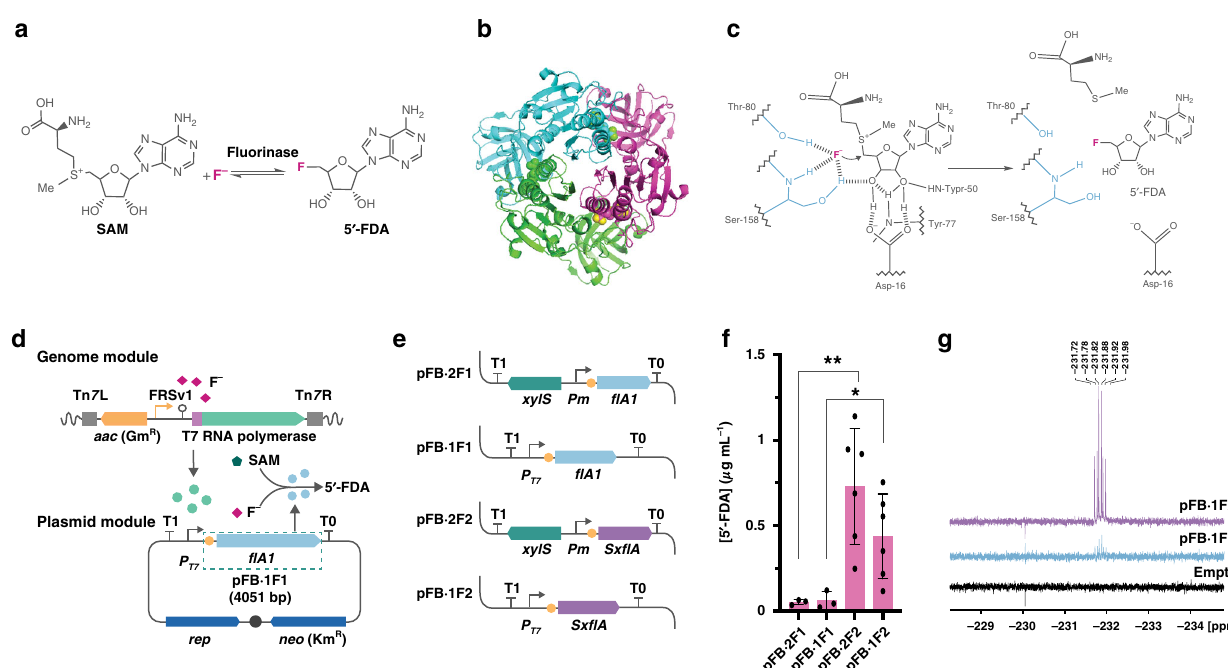
Fig. 2 In vitro bio fl uorination in cell-free extracts of engineered P . putida . a Bio fl uorination reaction, indicating the transformation of SAM ( S -adenosyl-L- methionine) and F − into 5 ′ -FDA (5 ′ - fl uoro-5 ′ -deoxyadenosine) by the fl uorinase enzyme. b 3D structure of the trimer form of fl uorinase (PDB ID 1RQP); SAM bound to the enzyme is represented as yellow spheres. c Mechanism of action of the fl uorinase enzyme. Functional groups that interact with F − (magenta) are indicated in blue. d Scheme of the synthetic circuit designed for fl uoride-triggered bio fl uorination. The T7 RNA polymerase gene (dark green) is integrated in the genome; upon exposure to F − (pink squares), the P T7 → fl A1 module (light blue, borne by plasmid pFB·1F1) is expressed and the FlA1 fl uorinase (light blue circles) is produced, catalyzing the conversion of SAM (green pentagon) and F − into 5 ′ -FDA. FluoroBrick 1, containing an RBS (yellow circle) and fl A1 , is boxed with dashed green lines. e FluoroBricks tested for 5 ′ -FDA biosynthesis. Genes encoding fl uorinases from Streptomyces sp. MA37 ( fl A1 ) and S. xinghaiensis ( Sx fl A ) were combined with the XylS/ Pm expression system or the FRS-T7 RNA polymerase circuit described in ( d ) by modular assembly. f 5 ′ -FDA biosynthesis in cell-free extracts of P . putida KT2440 bearing the FluoroBrick constructs described in ( e ). Data are presented as mean values and error bars correspond to standard deviations of at least three different biological replicates. An unpaired t-test analysis was used to compare 5 ′ -FDA biosynthesis across experiments, with one asterisk indicating a p value = 0.0410 and two asterisks identifying a p value = 0.0121. g 19 F- NMR spectra of the cell-free extracts. Key chemical shifts corresponding to 5 ′ -FDA are indicated. Source data underlying Fig. 2f are provided as a Source Data fi